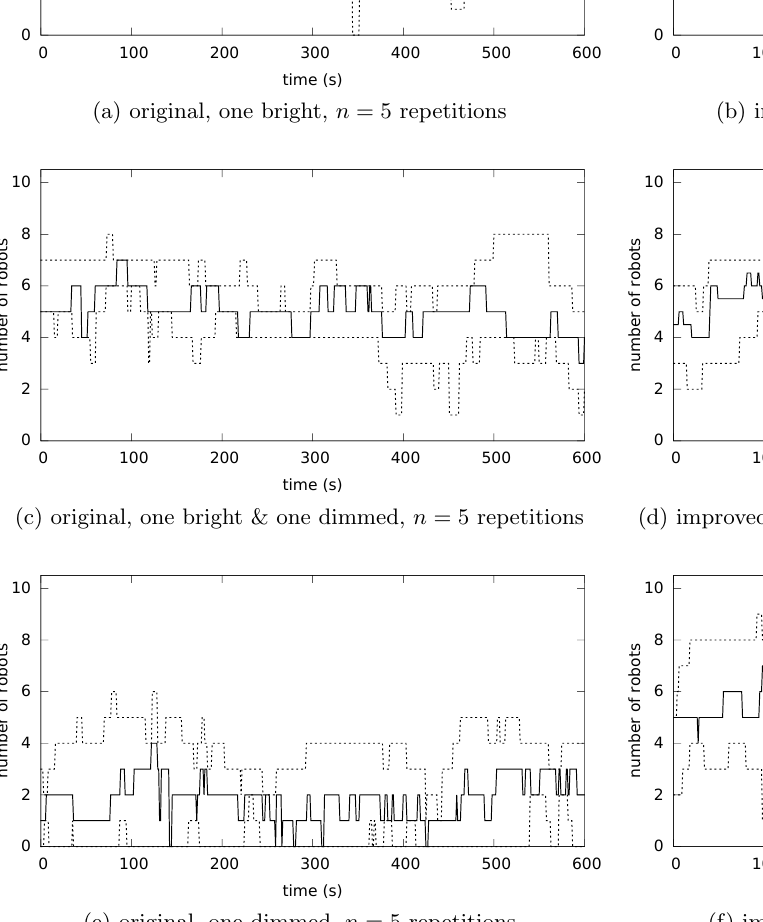
(f) improved, one dimmed, n = 5 repetitions Figure 9: The minimum, maximum, and median number of stopped robots in zone I (brighter zone) during a ten-minute time interval for each experiment